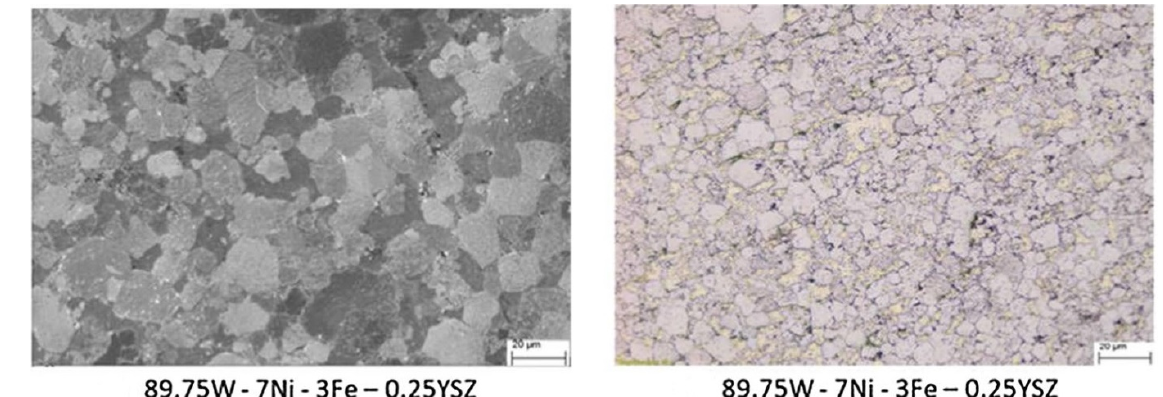
Figure 14. The SEM and optical micrographs of SPS-sintered alloy with 0.25 wt% yttria-stabilized zirconia (YSZ) [89]. “Reproduced with permission from Muthuchamy et al., Arabian Journal for Science and Engineering; published by Springer”.